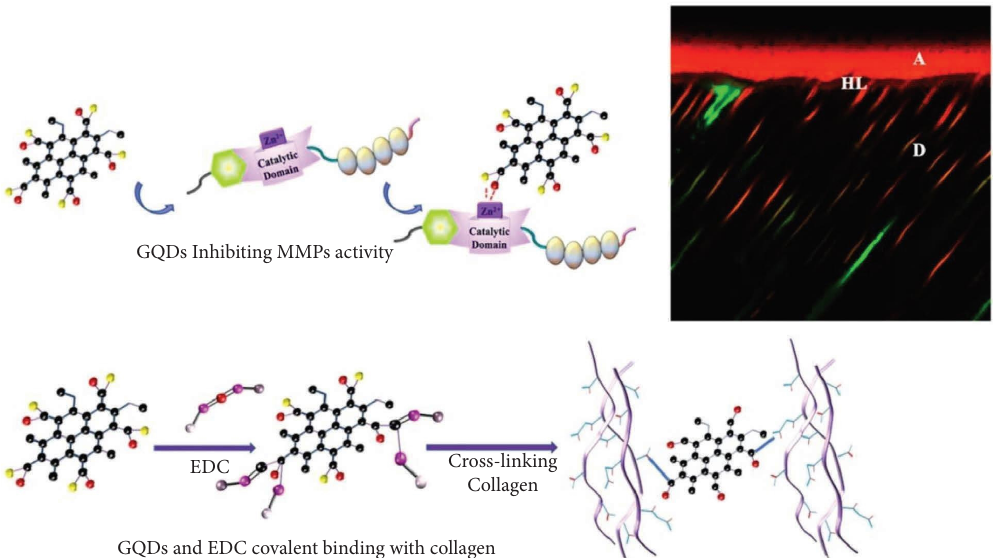
Figure 8: Schematic of graphene quantum dots and EDC inhibiting MMP activity to decrease dentin demineralization (reprinted with permission from Chen et al. [91]) (Copyright 2021,